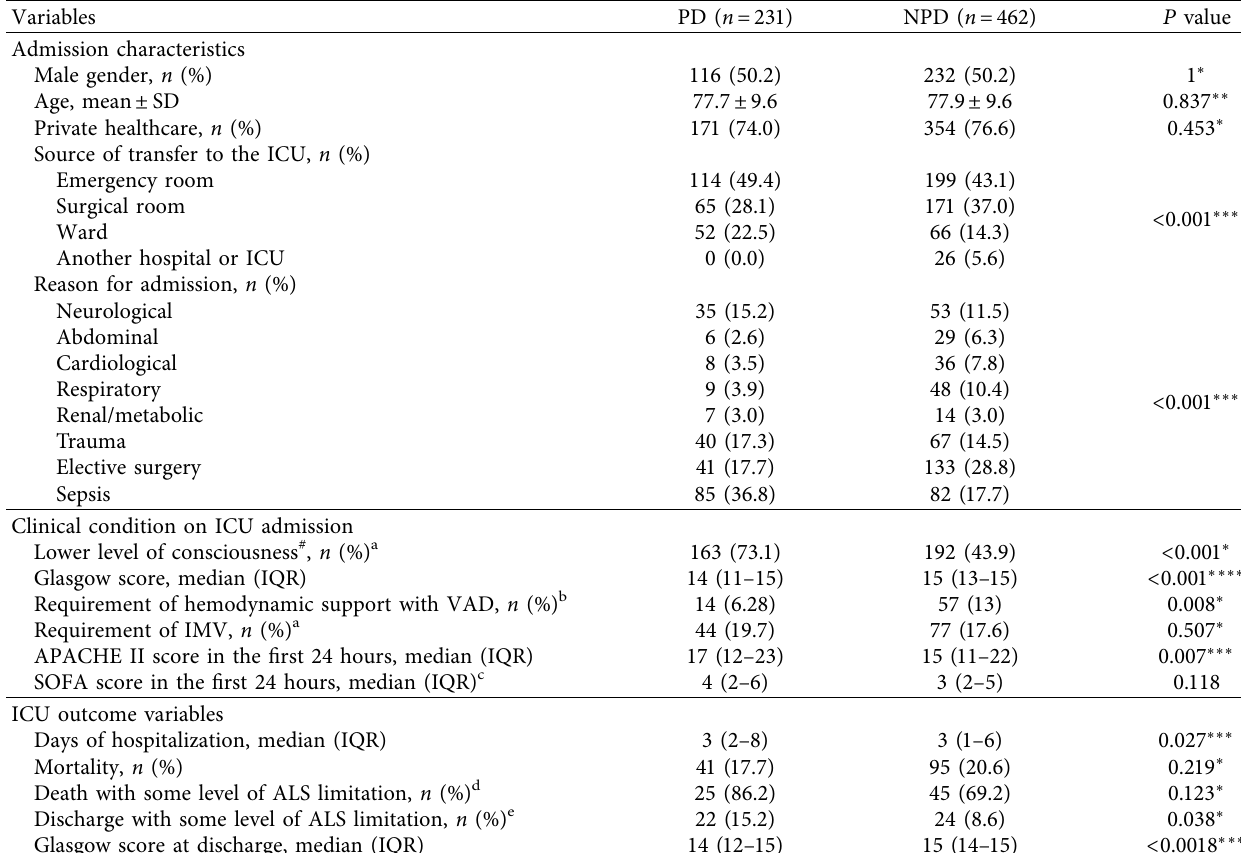
Table 1: Epidemiological and clinical characteristics of the study groups.